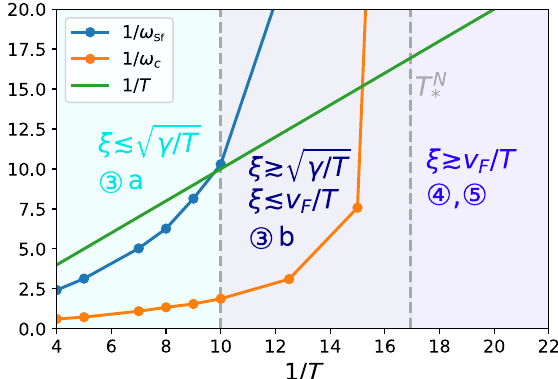
v = ξ and c ¼ F ffiffiffiffiffiffiffiffi p γ =T =T ). and v F